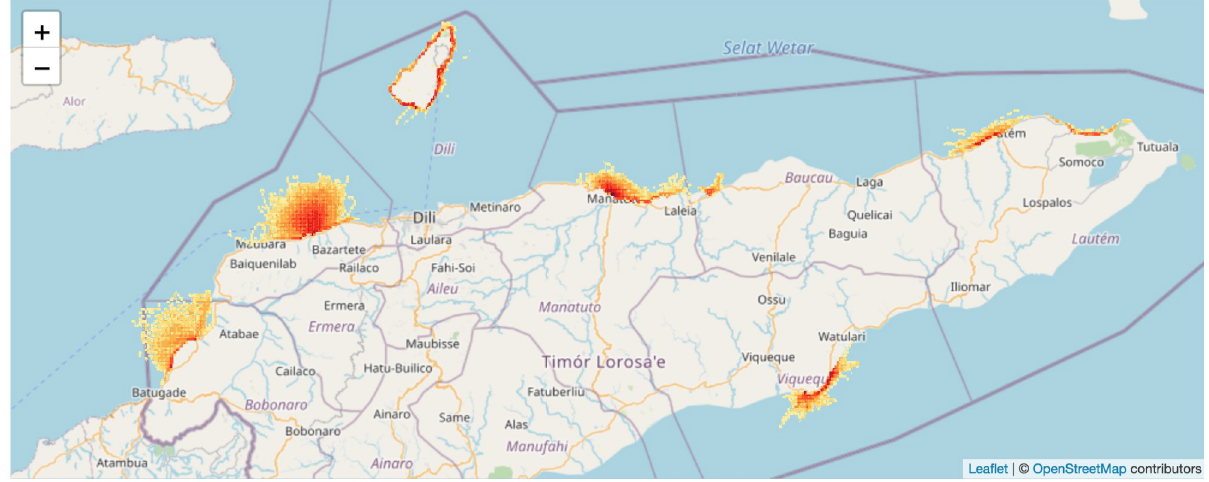
Fig 4. The relative effort heat map of small-scale fishing vessel tracks between August 2018 and February 2020 in Timor-Leste from the PeskAAS dashboard. Red shading represents areas of highest effort (near to homeports and shore), and orange to yellow shading shows areas fished with decreasing effort further from shore. Map data © OpenStreetMap contributors. Map layer by Esri via leaflet [23].